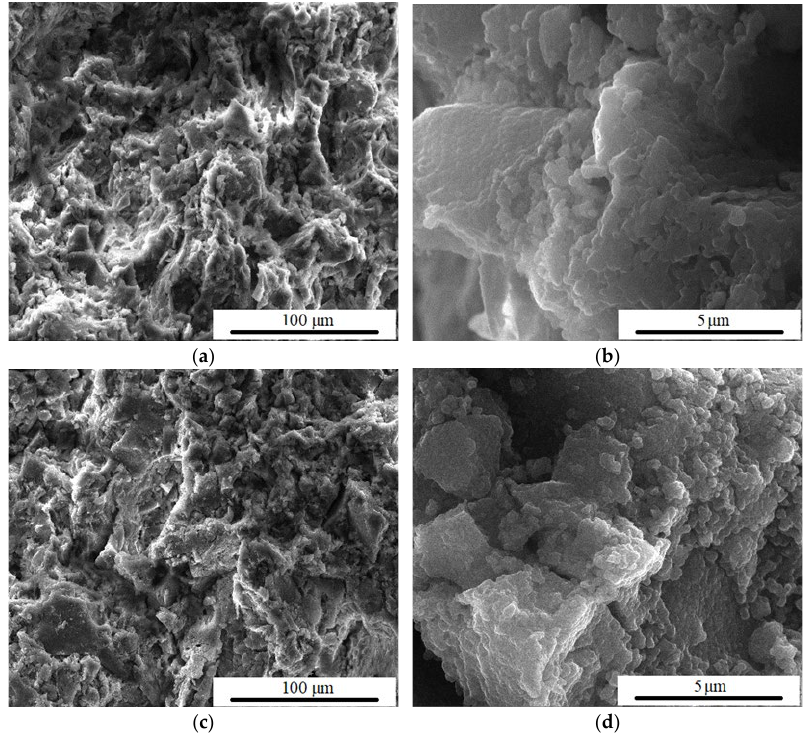
Figure 11. SEM images magnification ×1000 and ×20,000 of F 2 ( a , b ) and F 2 20s ( c , d ) samples, after 14 days in SBF.